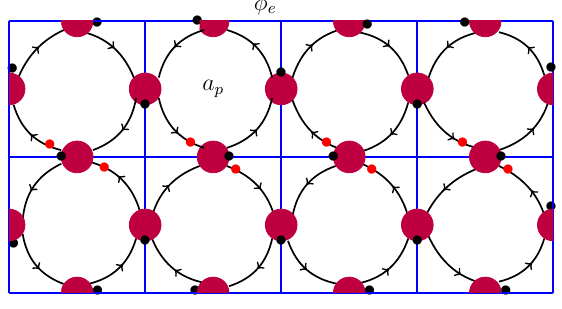
Figure 8 . Example of a tensor network for a graph Γ . The reason of the presence of the red bullets will become clear in figure 11.